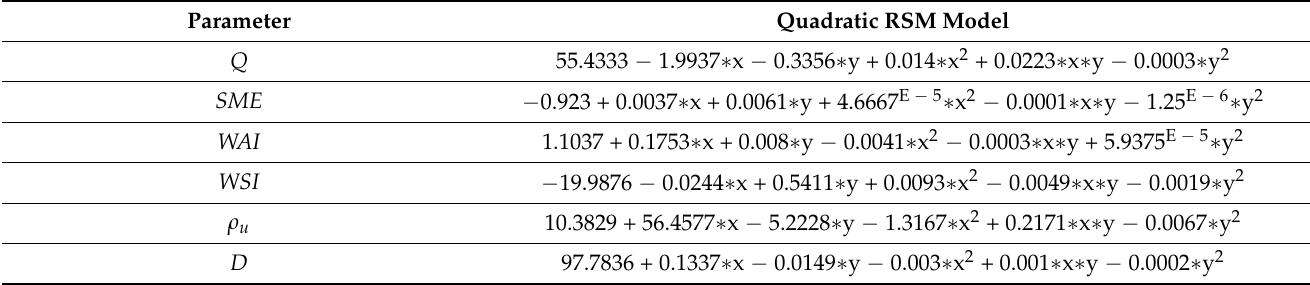
Table 2. Multiple regression equations of process efficiency and energy consumption and physical properties of extruded corn bran.